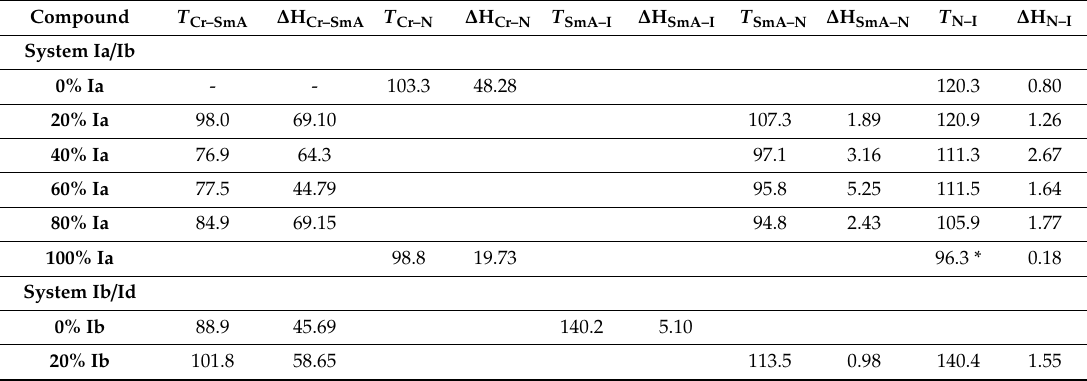
Table 1. Phase transition temperatures ( ◦ C) and enthalpy of transition ∆ H, kJ / g for binary mixtures% upon the second heating